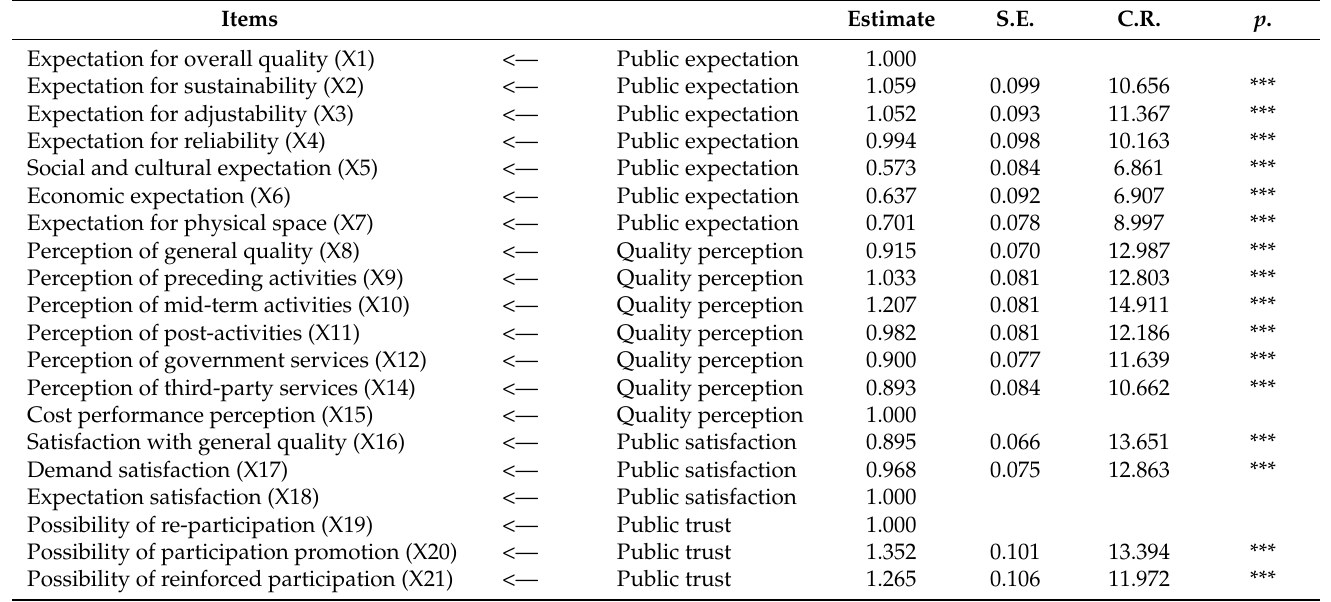
Table 6. Weight and score of each factor.